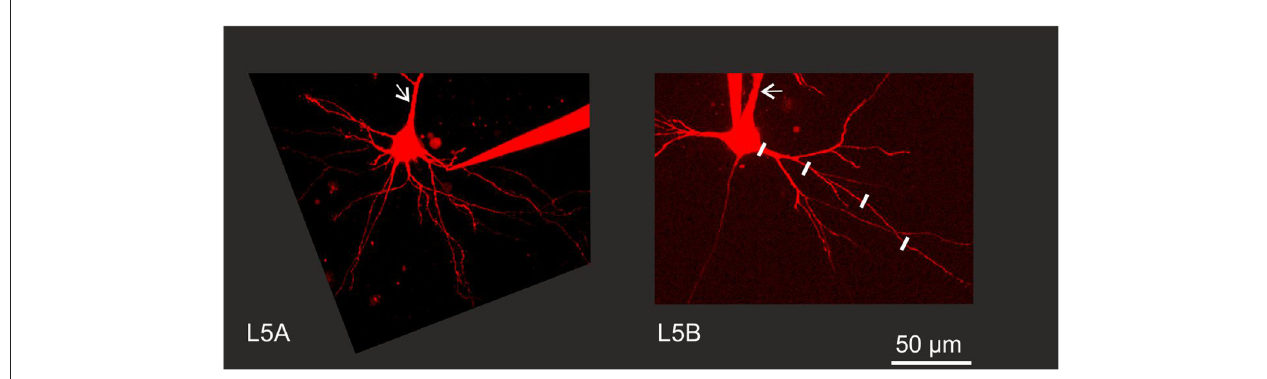
FIGURE 1 | Experimental configuration. Neurons were filled with Alexa 594 to permit visualization of fine morphological details. Back-propagating action potential (BAP) evoked calcium responses were measured in line scan mode at various increments along the dendrite as illustrated by the white lines along one branch of a Layer 5B thick-tufted (L5B-tt) cell basal dendrite. Arrows indicate the apical dendrite. Note the thinner apical and basal dendrites close to the soma in the L5A slender-tufted (L5A-st)